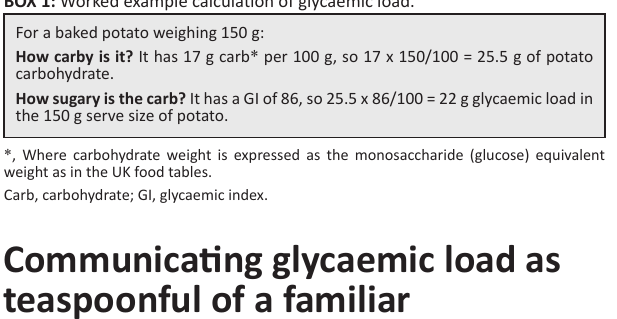
FIGURE 1: An improved version of the infographic shared with health professionals to show how the glycaemic index helps inform dietary choices.